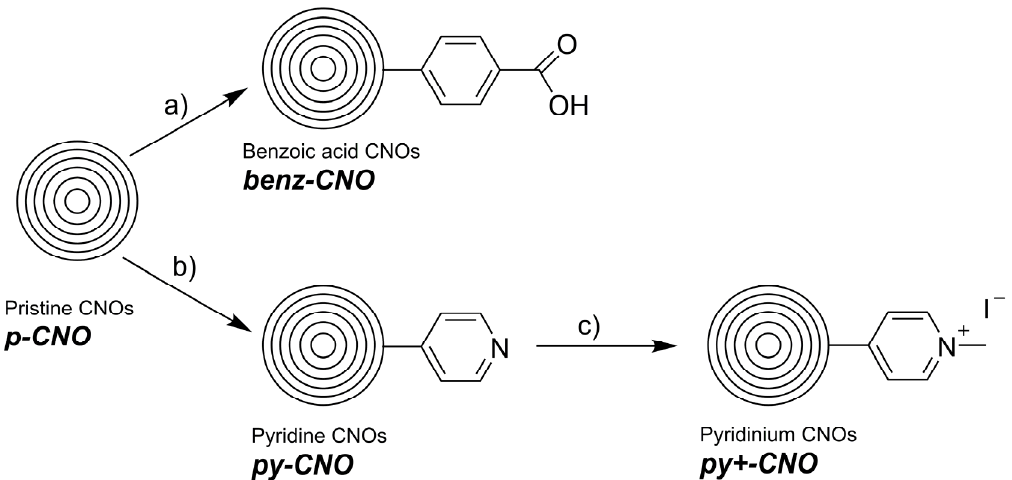
Figure 2. Scheme of synthetic procedures for the surface functionalization of pristine CNOs. ( a ) 4-Aminobenzoic acid, NaNO 2 , HCl, dimethylformamide/water; ( b ) 4-Aminopyridine, NaNO 2 , 4 N HCl/dimethylformamide. ( c ) Iodomethane, acetonitrile. All CNOs contain multiple functionalities on the surface; this scheme is simplified.